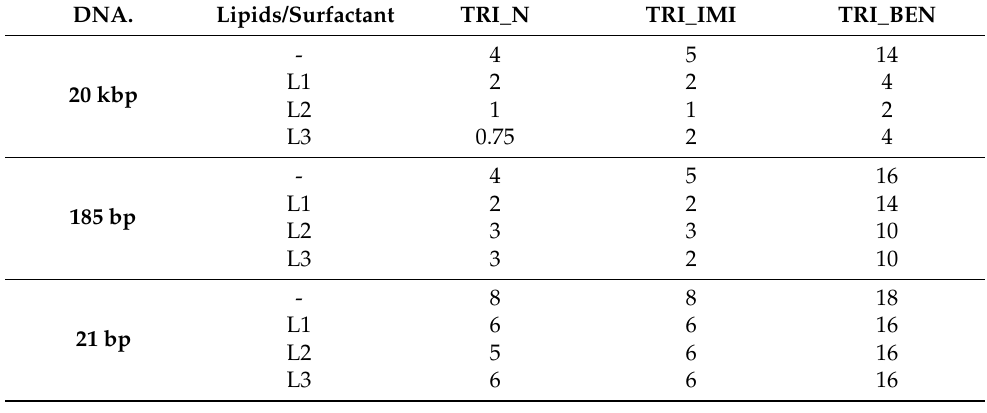
Table 1. The efficiency of the binding of the nucleic acid by studied systems. DNA.